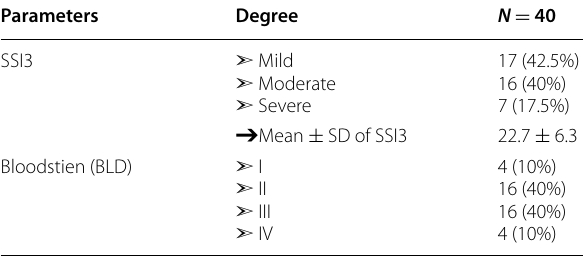
Data expressed as number (%) or mean